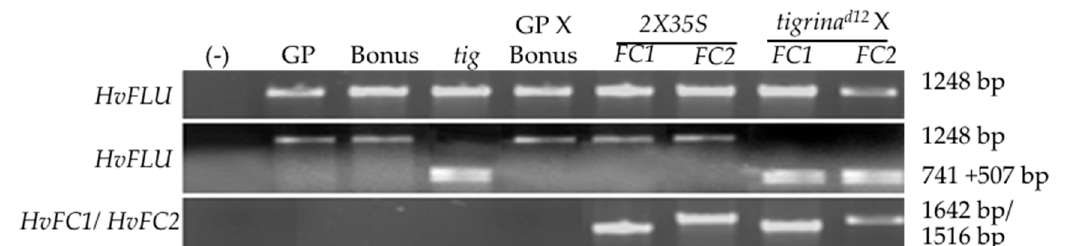
Figure 6. Molecular characterization of tigrina d12 mutants overexpressing HvFC1 or HvFC2 using CAPS markers and transgene specific primers. PCR was conducted using FLU specific primers (top panel). The PCR amplicons were cleaved using HaeIII restriction enzyme, and tigrina d12 mutants could be differentiated from other plants based on the cleaved fragment sizes (middle panel). The presence or absence of the transgenes was detected by using the transgene specific primers (bottom panel). Lane (-) is the negative control.